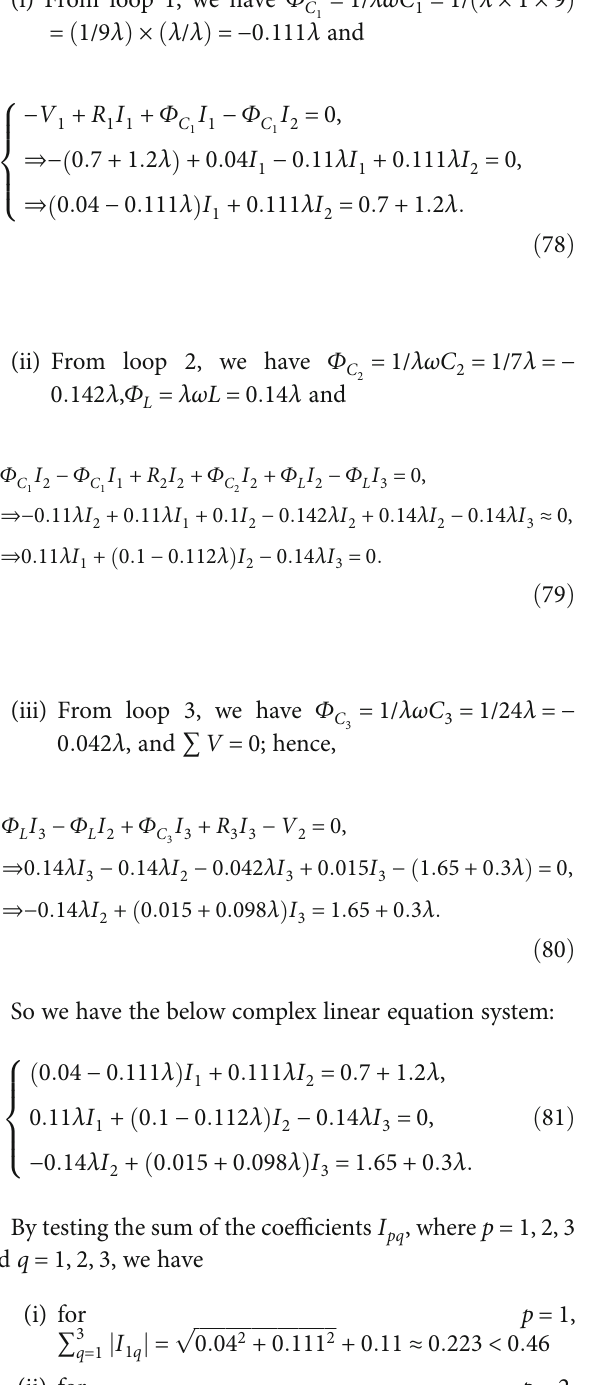
Veri fi cation: from Kirchho ff voltage law “ the sum of all voltage in a closed loop is zero ” ; in this example, we observe it in three loops (Figure 1). From our simple physical infor- mation, we know that V = IR = I Φ C = I Φ L , where Φ C = 1/ λ ω C and Φ λω L L =